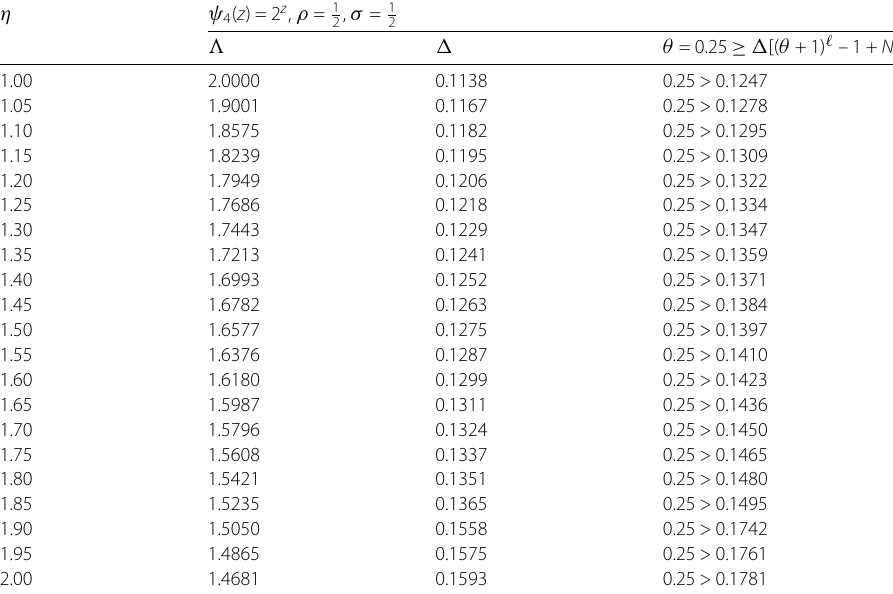
Table 4 Numerical results of (cid:27) and θ for ψ 4 ( z ) = 2 z and η ∈ J = [1,2] in Example 5.1